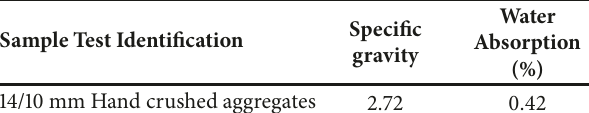
Table 2: Summary of laboratory test results for specific gravity and water absorption tests ( see Figure S1–S3 in the Supplementary Materials for comprehensive